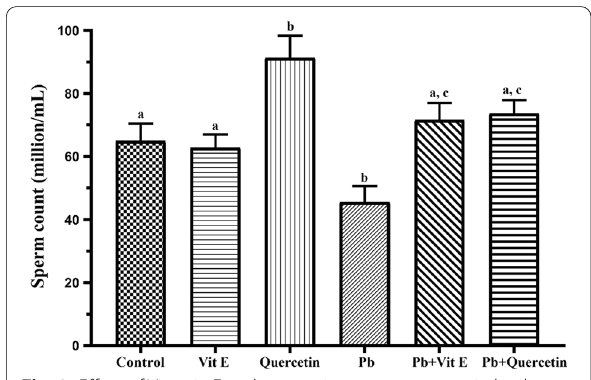
Fig. 3 Effect of Vitamin E and quercetin on sperm count in lead acetate treated male Wistar rats. Bars represent mean bearing different superscripts between groups differ significantly at p <